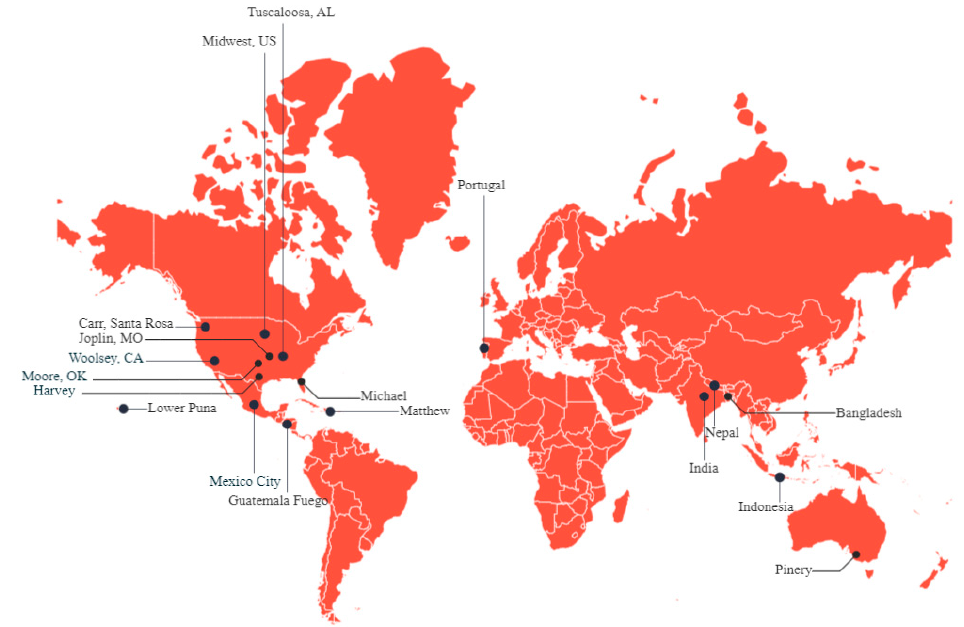
Figure 3. The locations from which data in the xBD dataset are collected [32]